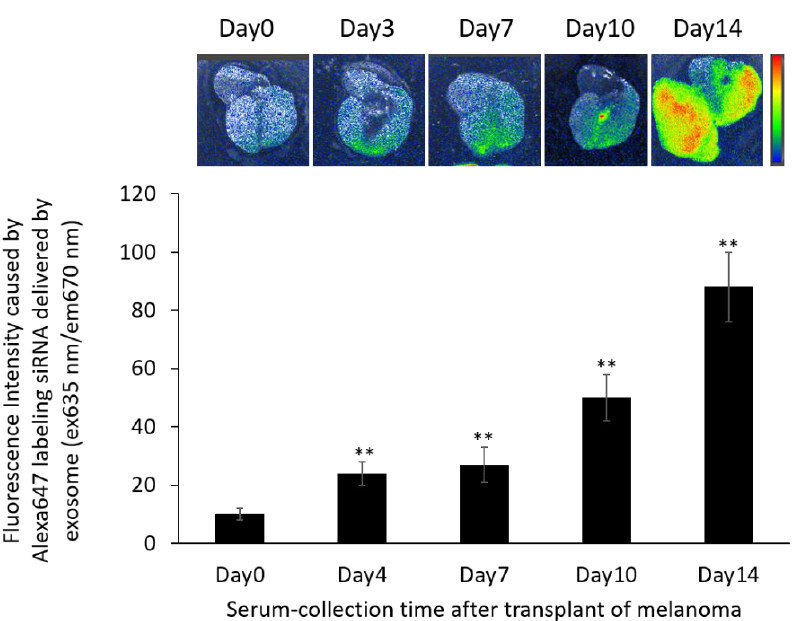
Figure 7. In vivo fluorescence imaging of the lung in B16/BL6 spontaneous lung metastasis model mice treated with Alexa647-labeled siRNA-loaded exosomes prepared from serum-derived exo- somes. Data were obtained 24 h after treatment with Alexa647-labeled siRNA-loaded exosomes. Data represent the mean ± SD of three independent experiments; ** p < 0.01 versus control B16/BL6 spontaneous lung metastasis model mice (Bonferroni test/ANOVA).